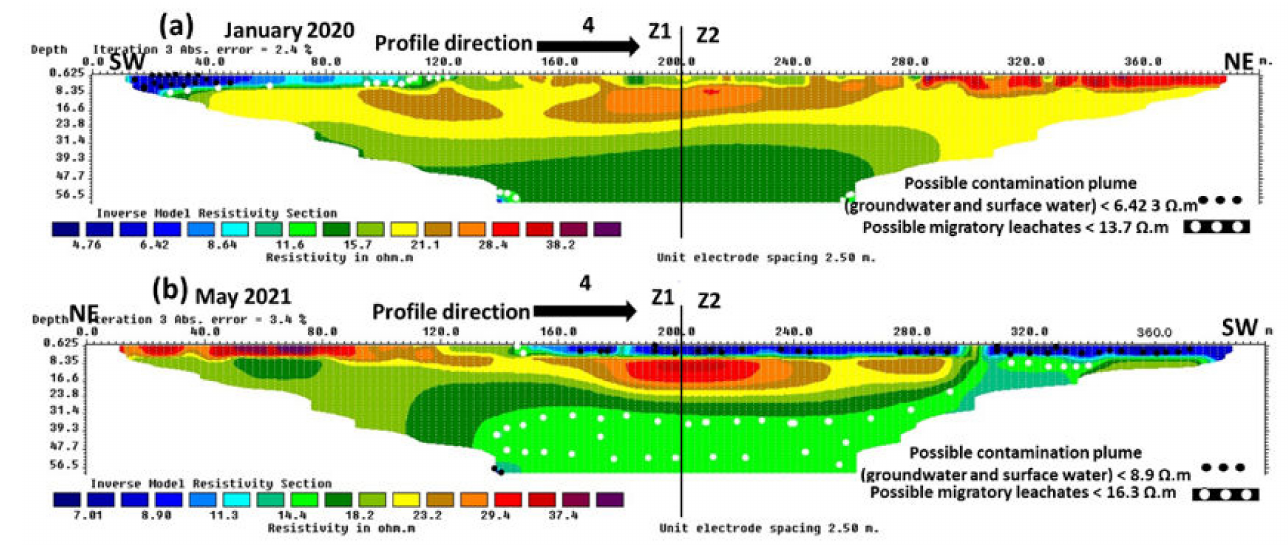
Figure 6. Electrical resistivity model of profile 4 in 2020 ( a ) and 2021 ( b